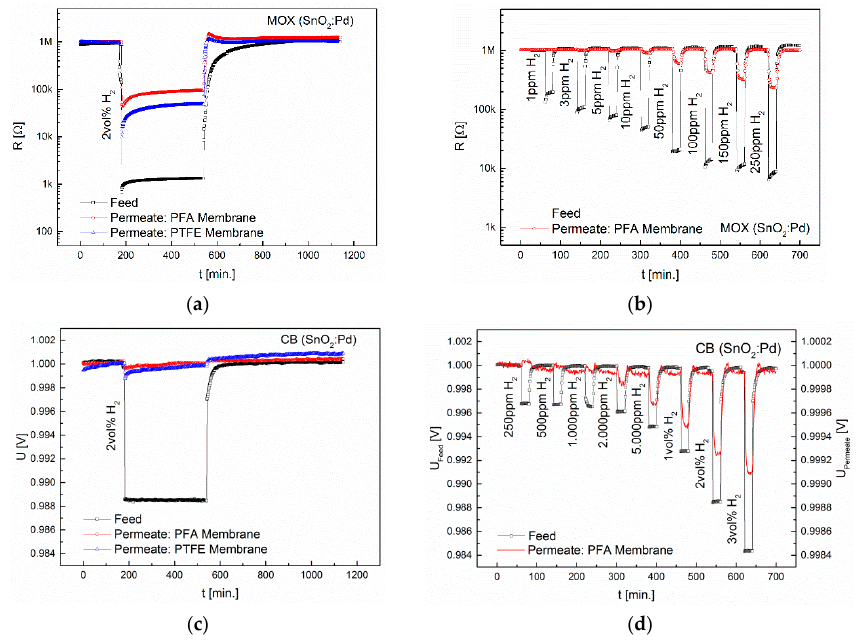
Figure 8. Interdependence of diffusion and sensor signal, measured with the MOX sensor. ( a ) Sensorgram of the MOX sensor in the Permeate and feed during 6 h exposure to 2 vol% H 2 using PFA and PTFE membranes; ( b ) Sensorgram of the MOX sensor during exposure to 1–250 ppm H 2 using the PFA membrane. (c) Sensorgram of the CB sensor in the Permeate and feed during 6 h exposure to 2 vol% H 2 using PFA and PTFE membranes; (d) Sensorgram of the CB sensor during exposure to 250ppm-3 vol% H 2 using the PFA membrane.